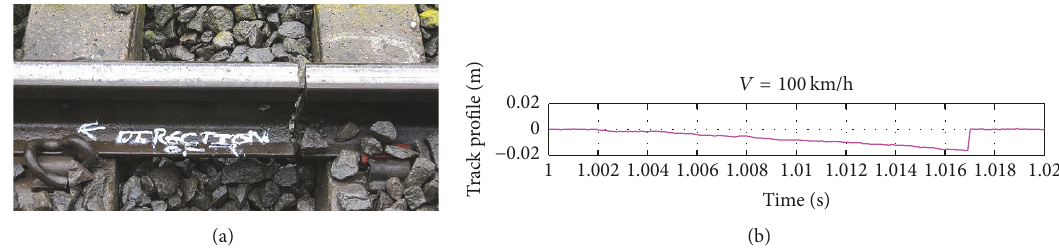
Figure 14: Broken rail with a disturbance surface: the real picture of the track profile (a) and the model when a train passes over it with a velocity of 100km/h (b).